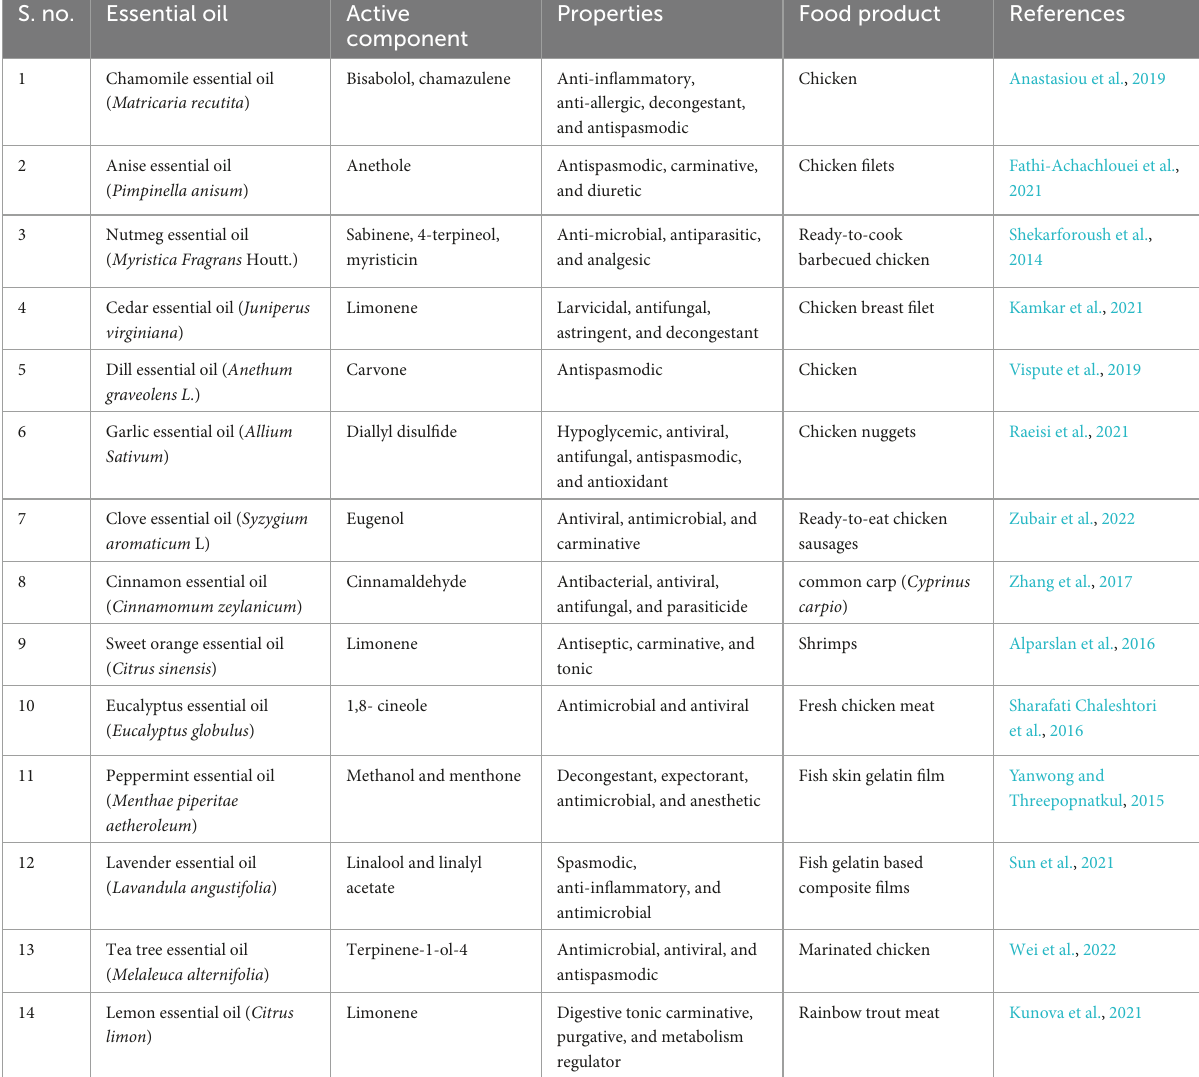
TABLE 2 Therapeutic benefits of using essential oils in chicken and seafood. S.